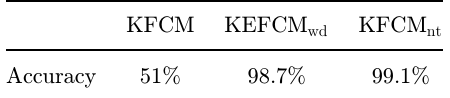
Table 2. Error matrix on Yeast